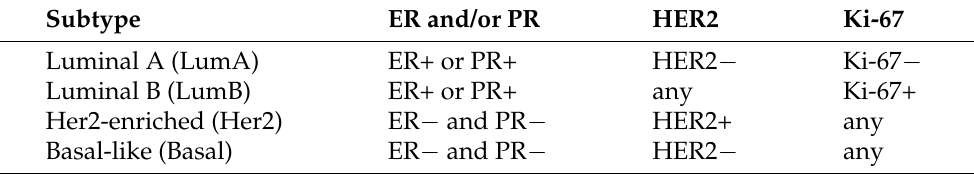
Table 1. Summary of the molecular subtypes according to immunohistochemistry assay in breast cancer. ER, PR, HER2, and Ki-67 mean estrogen receptor, progesterone receptor, human epidermal growth factor receptor 2, and marker of proliferation,